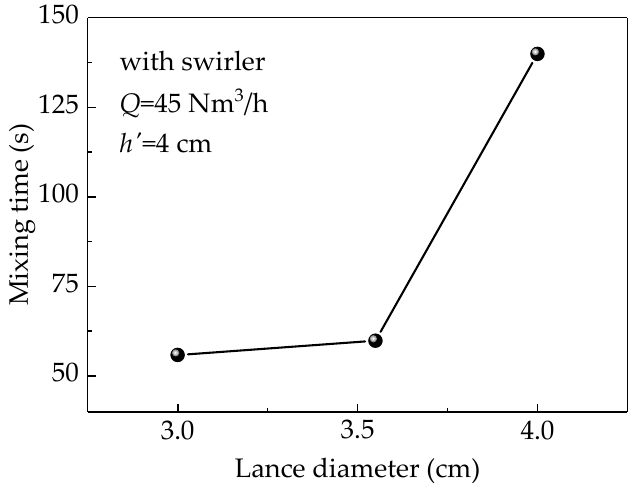
Figure 9. Simulated results of the relationship between mixing time and lance diameter.